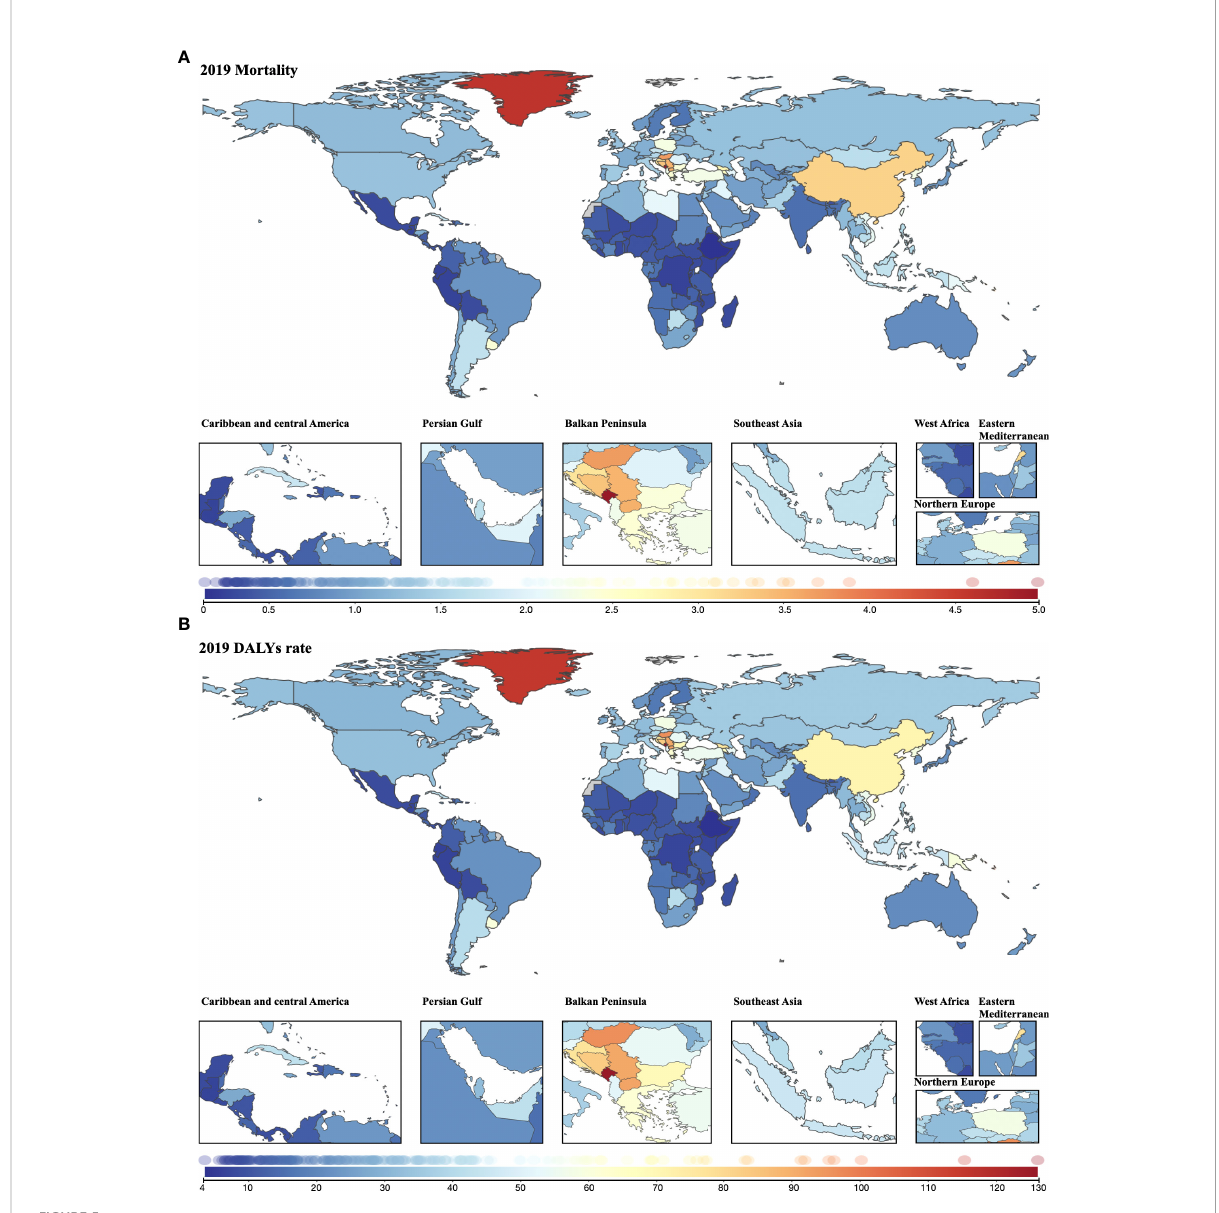
FIGURE 5 Geographical distribution of cancer burden attributable to secondhand smoke for both sexes combined in 2019. (A) Mortality; (B) DALYs